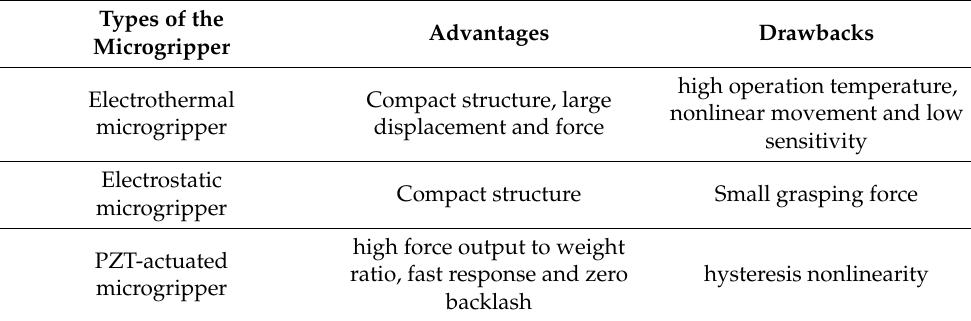
Table 1. The features of different kind of microgrippers.